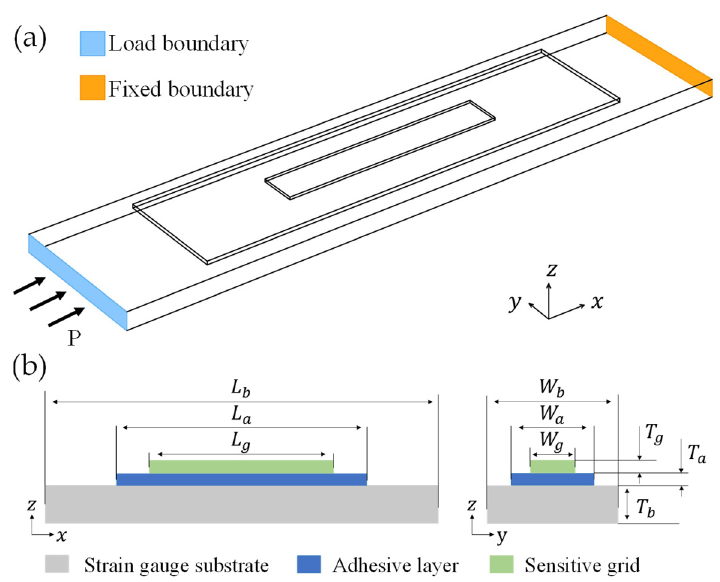
Figure 4. Geometrical model ( a ) and schematic cross section ( b ) of sensitive grids for the simulation calculations. The boundary conditions and the geometrical dimensional sizes are marked in the drawings. Table 1. Basic material parameters of three layers.